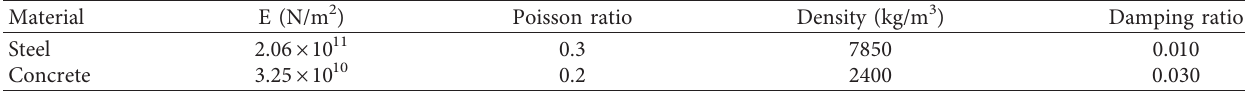
Table 1: Material properties of SESB.